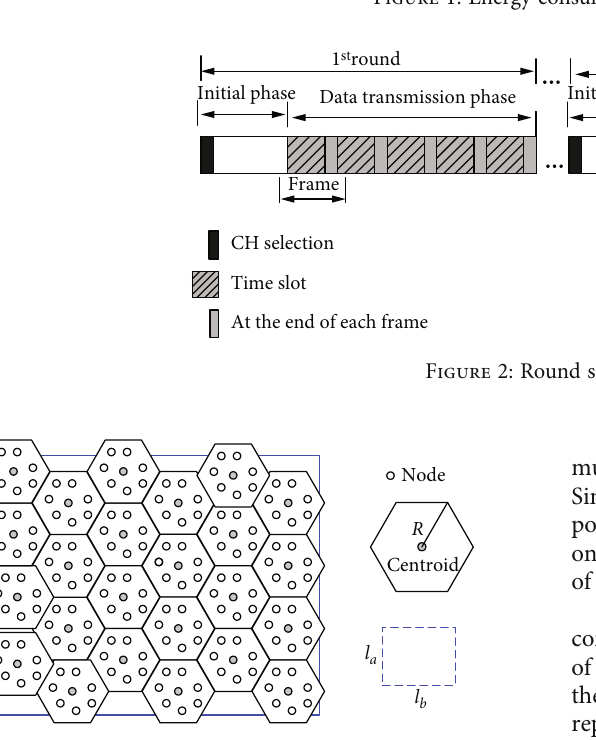
Figure 3: Hexagonal grid-based cluster